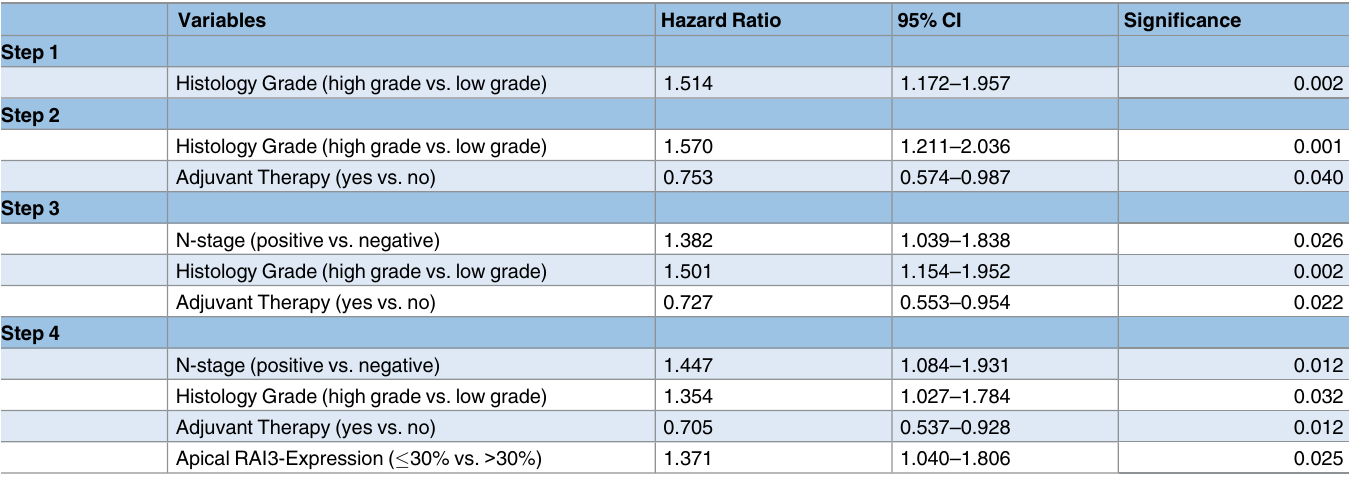
Table 2. Multivariate Cox proportional hazard model for different